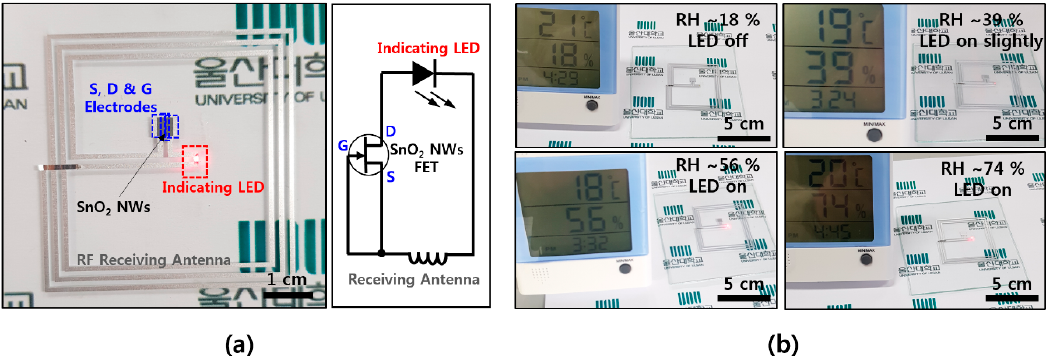
Figure 4. Wirelessly operated humidity sensor ( a ) NFC-based wireless humidity sensor device and its circuit diagram; ( b ) humidity-sensing operation with red LED indicator as a function of RH ~18%, ~39%, ~56%, and ~74%.